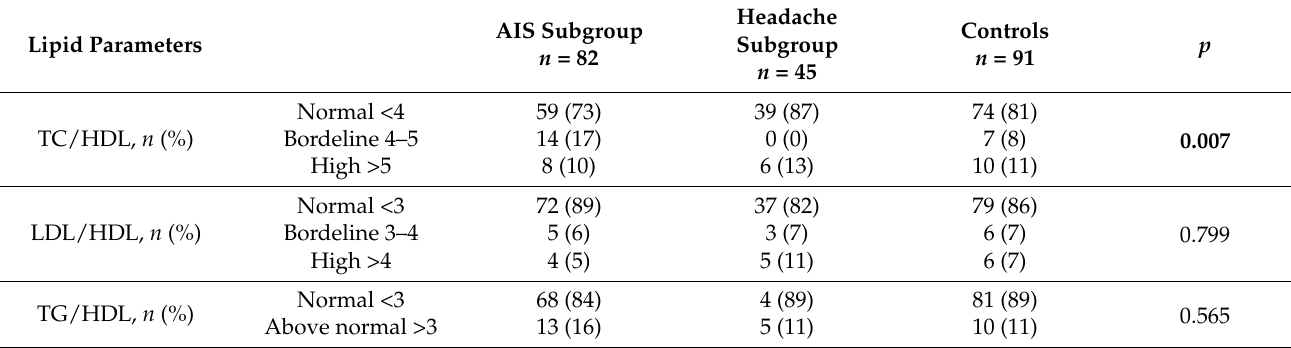
Table 3. Prevalence of lipid ratios’ intervals in analyzed